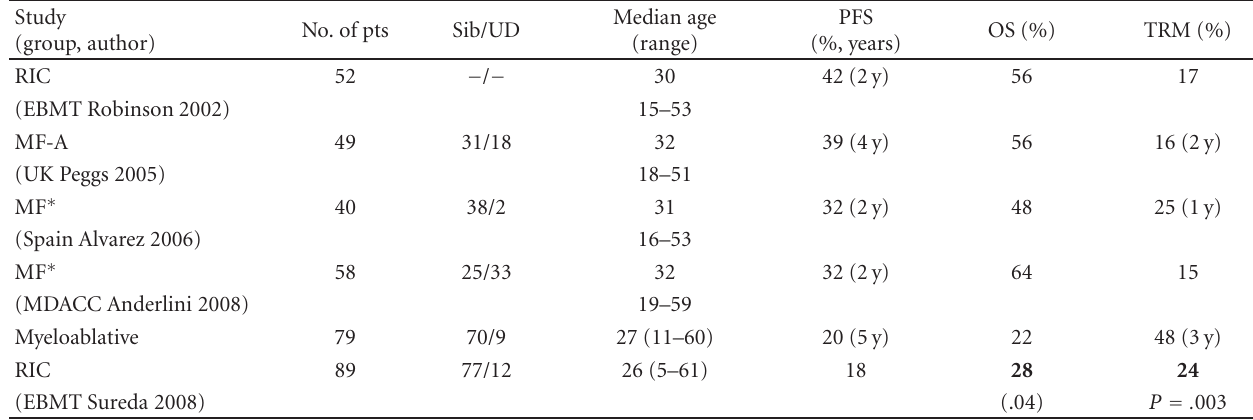
Table 9: Registry data of outcomes of reduced intensity conditioned (RIC) allogeneic transplants in relapsed and refractory Hodgkin’s lymphoma. Numbers in bold are statistically significant with P values where significant. ∗ Antithymocyte globulin given to unrelated donor recipients. Abbreviations: Sib/UD: sibling/unrelated donor; PFS: progression-free survival; OS: overall survival; TRM: treatment-related mortality; M: melphalan; F: fludarabine; A: alemtuzumab; MDACC: MD Anderson Cancer Center; EBMT: European Group for Blood